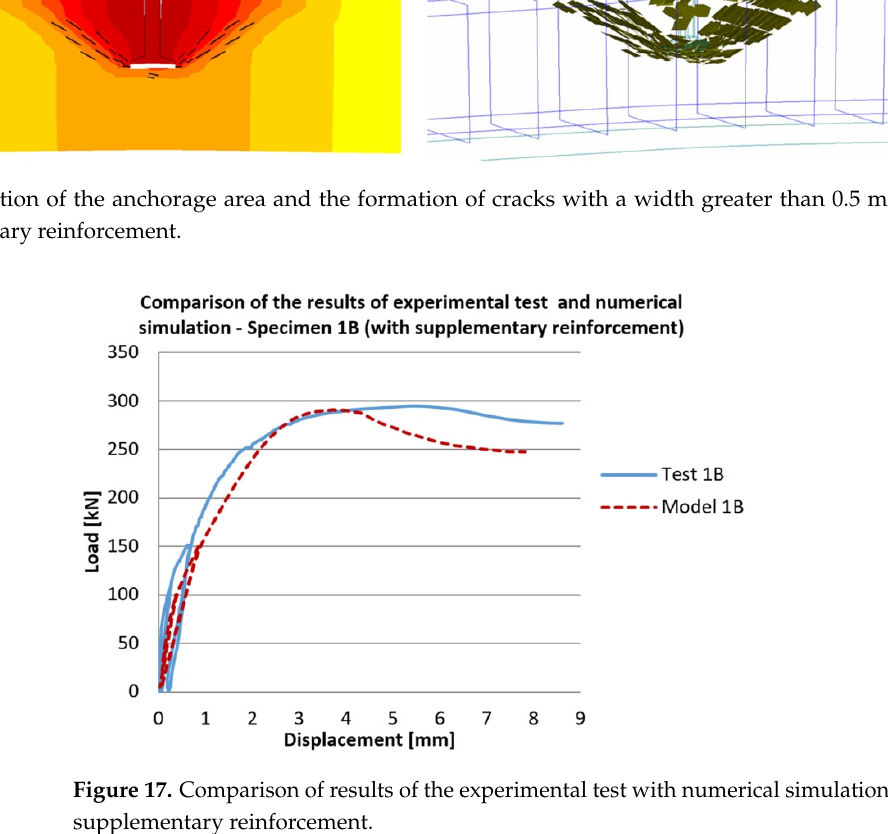
Figure 16. Deformation of the anchorage area and the formation of cracks with a width greater than 0.5 mm—anchor without supplementary reinforcement.